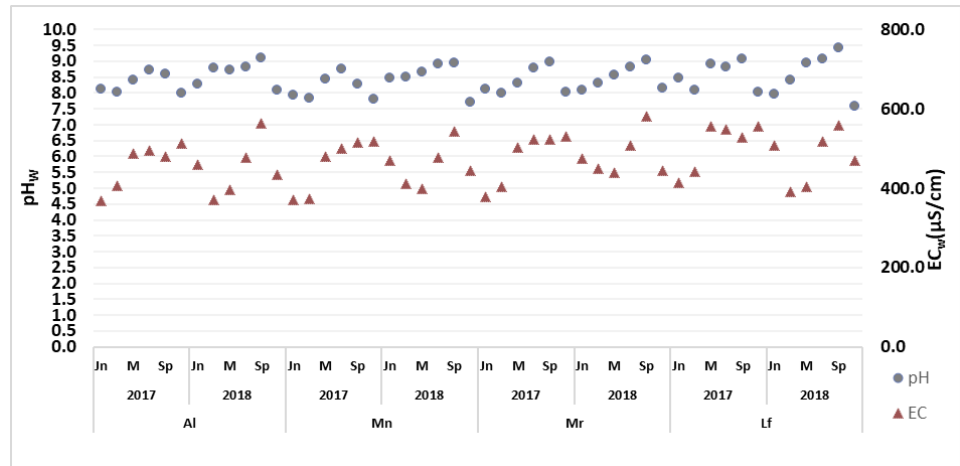
Figure 7. Values of pH w and electric conductivity (EC w ; µS/cm) measured in situ of each location (Al: Á lamos; Mn: Montante; Mr: Mourão; Lf: Lucefécit), during the study.